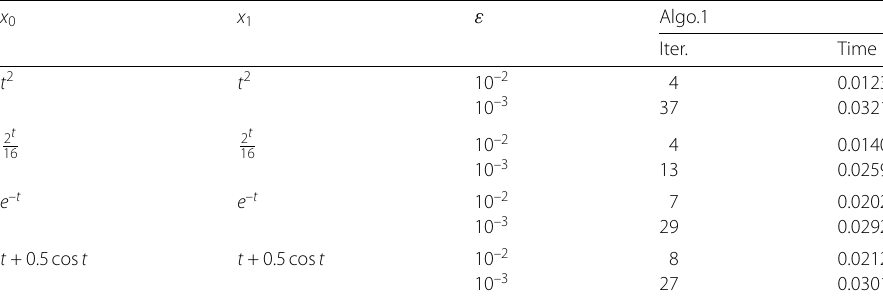
for Example n +1